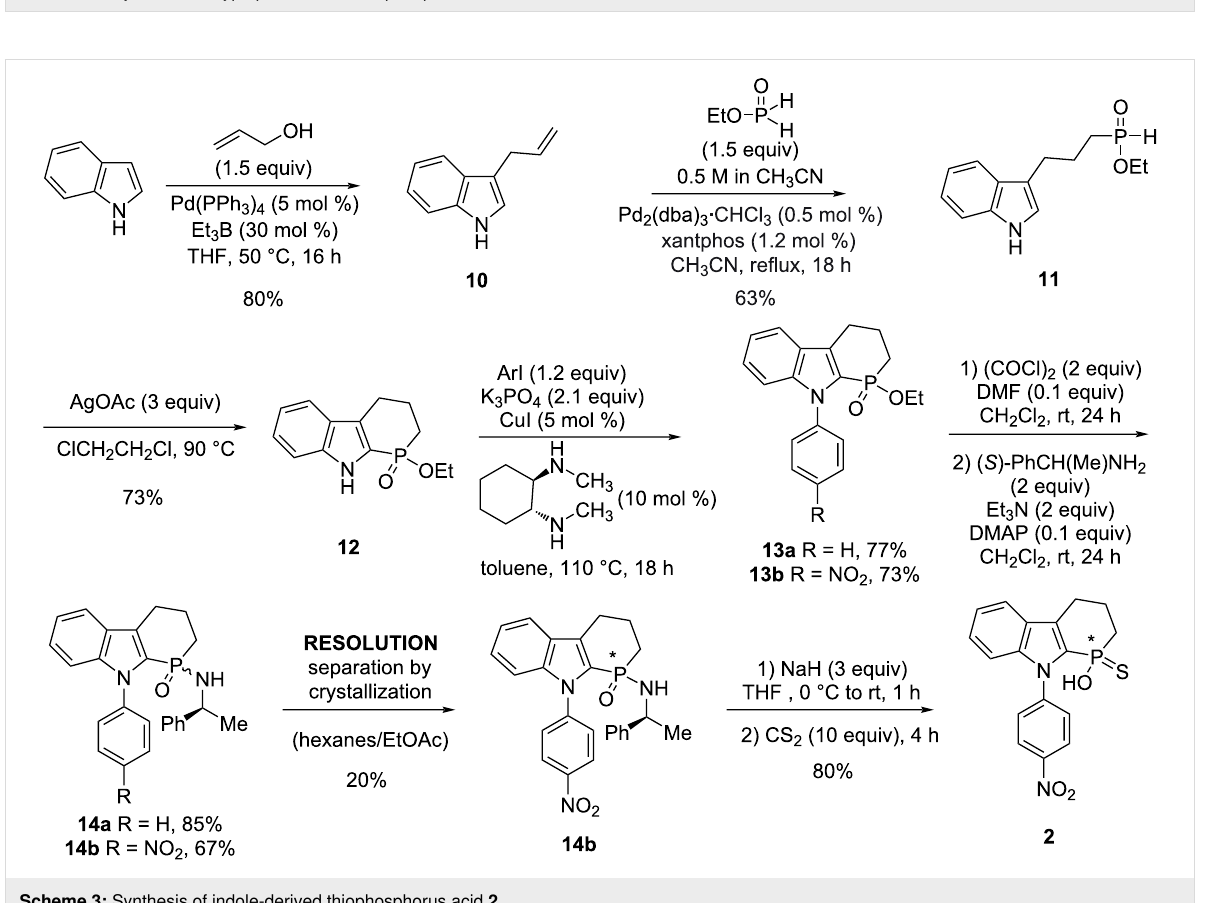
Scheme 2: Synthesis of tryptophol-derived thiophosphorus acid 1 .